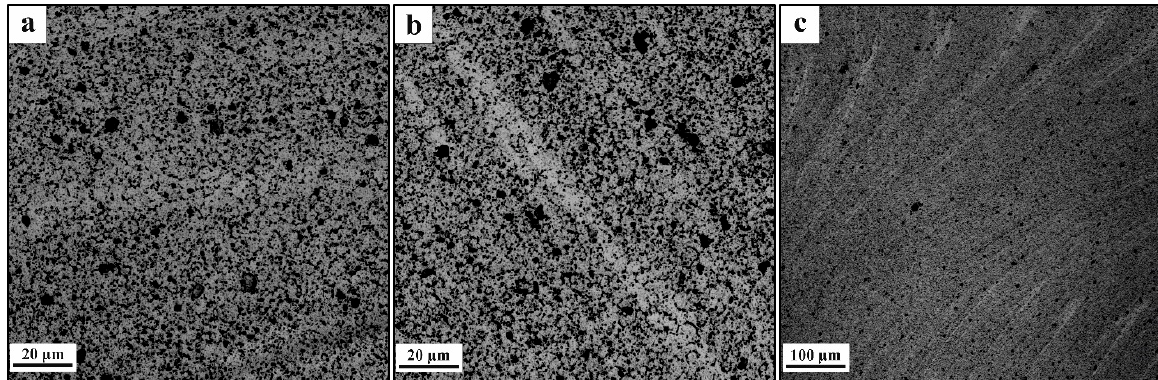
Figure 8. Microstructure of FSP-ed RPPs/AA5056 composite after 8 passes: ( a ) stir zone; ( b ) thermo- mechanically affected zone; ( c ) zone accumulations of RPs.